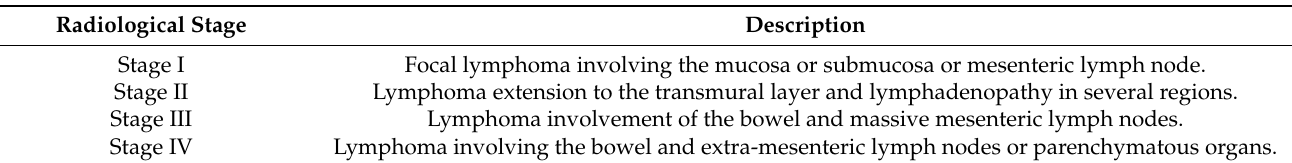
Table 2. Vessal et al. radiological staging of